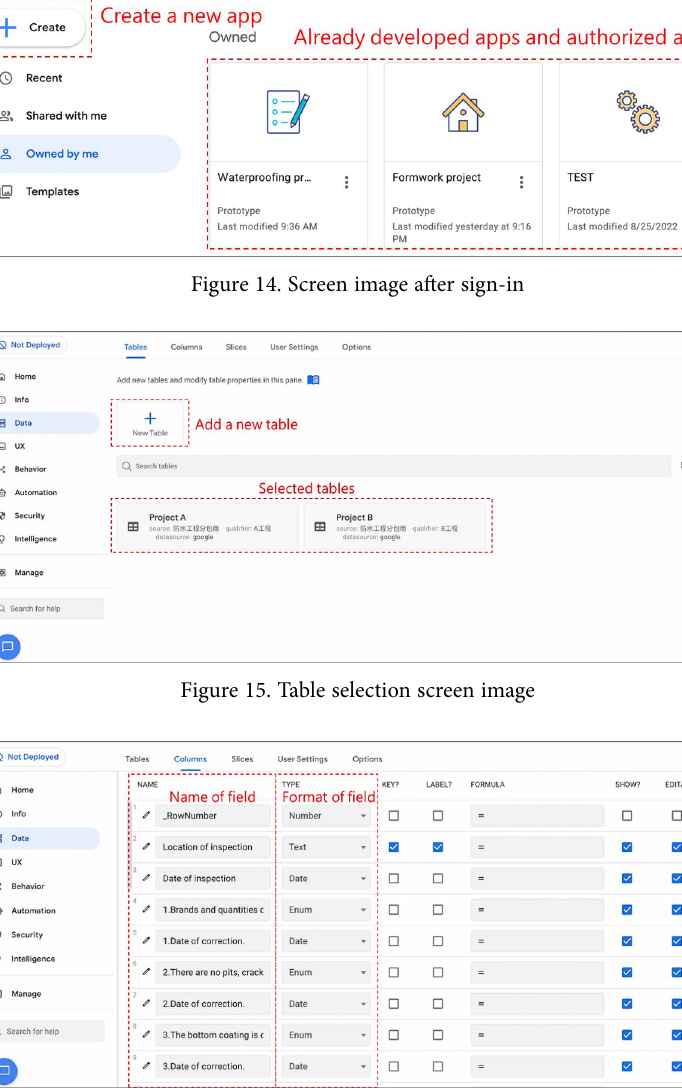
Figure 16. Field format setting screen